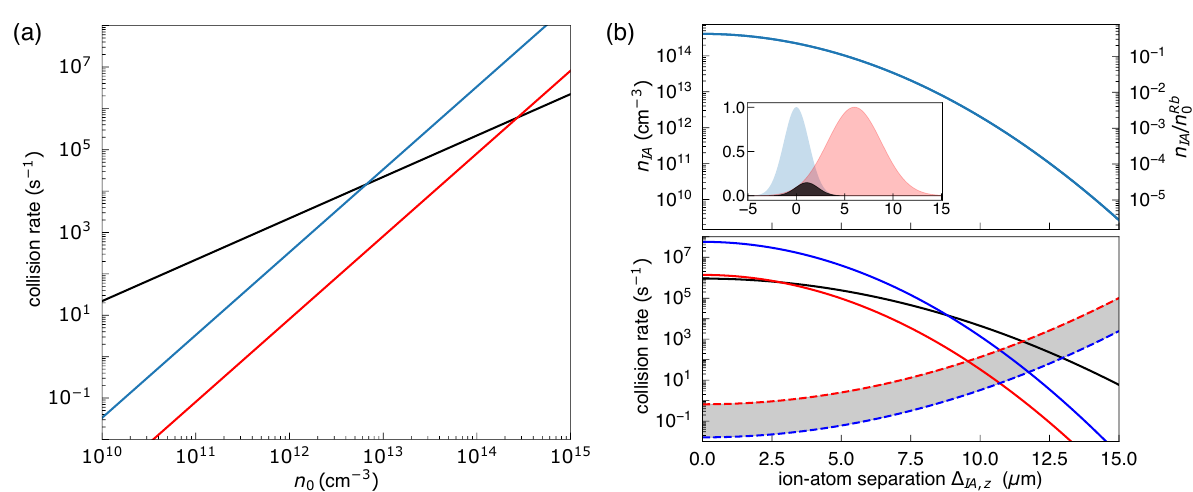
Figure 8. ( a ) Calculated Langevin collision rate γ Lgvn (black line) and the three-body recombination rate γ 3 b for an ion with a kinetic energy of E kin = k B × 370 µ K (red line) and an ion with E kin = k B × 1 µ K (blue line). ( b ) Top panel: Effective (left axis) and normalized (to n Rb ) (right axis) rubidium density probed by a barium ion prepared at T D ≈ 370 µ K (red shaded 0 area) positioned at a distance of ∆ IA , z from the center of an atomic cloud (blue shaded) cooled to T at = 1 µ K. The inset shows the calculated axial overlap (black area) for a separation of ∆ IA , z = 6 µ m. Bottom panel: calculated Langevin (black solid line) and three-body recombination (red and blue solid lines) rates, γ Lgvn and γ 3 b , respectively, for a Ba + ion prepared at T D (red) and after assumed thermalization to T at (blue). The corresponding ratios γ Lgvn / γ 3 b are shown as red and blue dashed lines, with curves for intermediate ion temperatures lying in the grey shaded